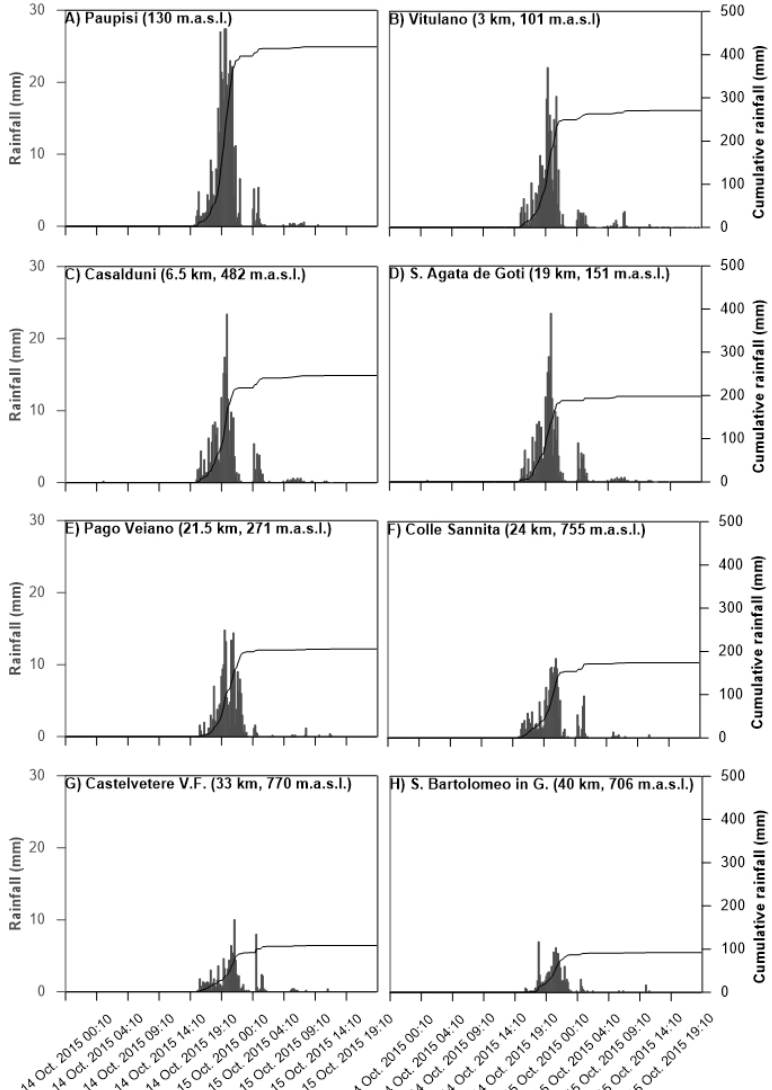
Figure 3. Ten-minute and cumulative rainfall registered during the event on 14–15 October 2015 by some significant stations, starting from the maximum peak of intensity (Paupisi). See Figure 2 for station locations. ( A ) Paupisi (130 m a.s.l.); ( B ) Vitulano (3 km, 101 m a.s.l.); ( C ) Casalduni (6.5 km, 482 m a.s.l.); ( D ) S. Agata de Goti I. (19 km, 151 m a.s.l.); ( E ) Pago Veiano (21.5 km, 271 m a.s.l.); ( F ) Colle Sannita (24 km, 755 m a.s.l.); ( G ) Castelvetere V.F. (33 km, 770 m a.s.l.); ( H ) S. Bartolomeo in G. (40 km, 706 m